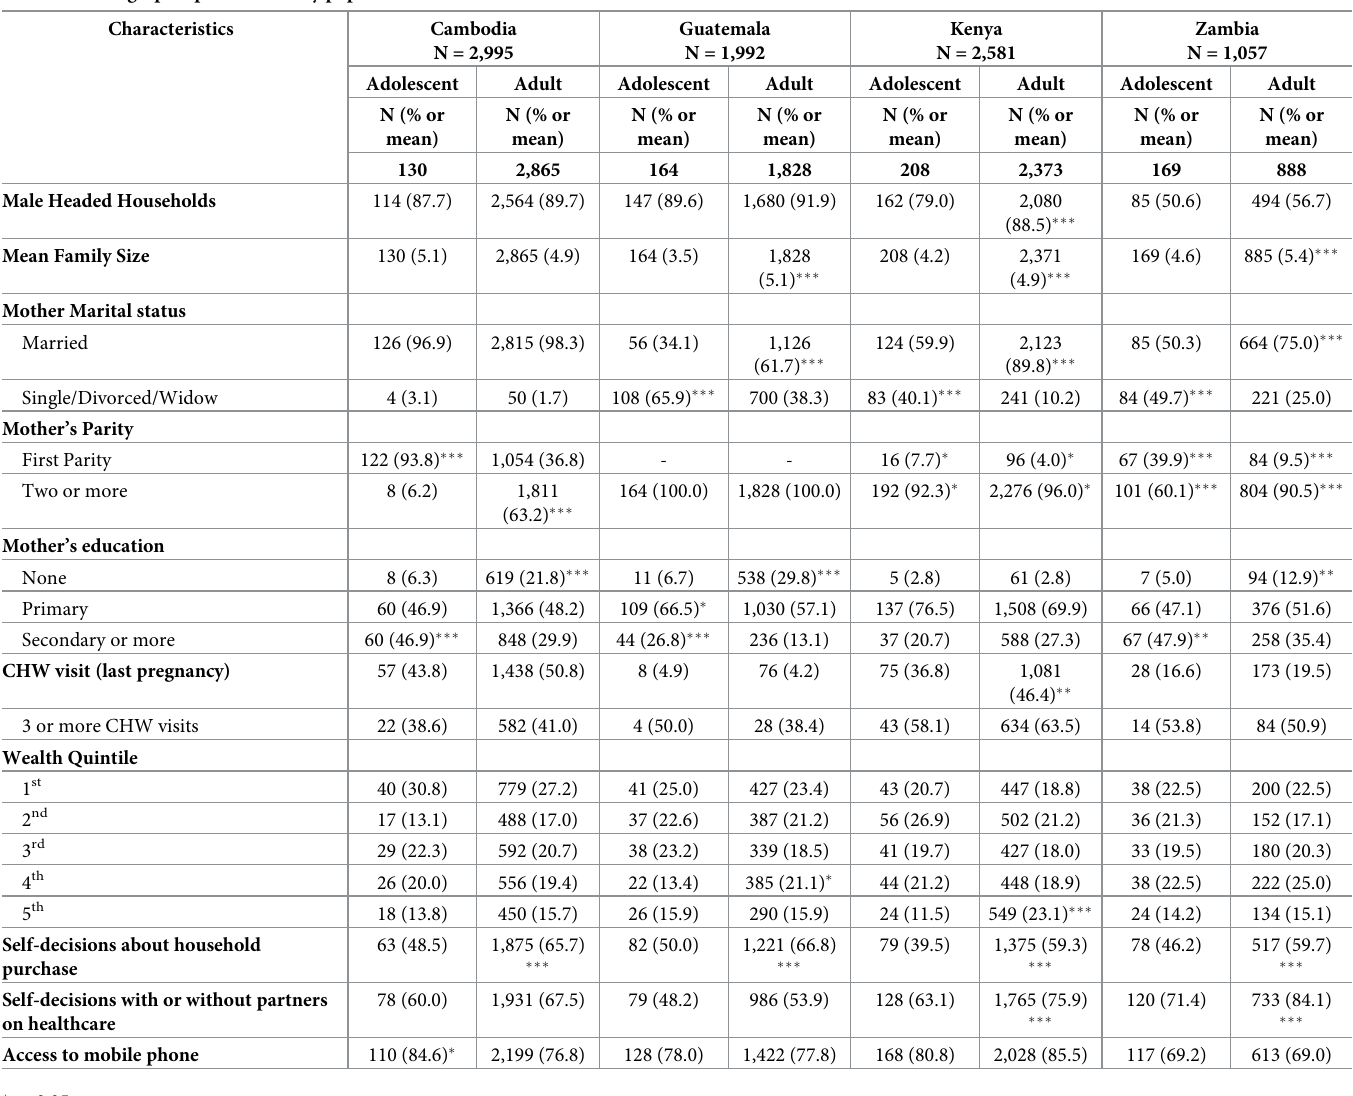
Table 2. Demographic profile of study